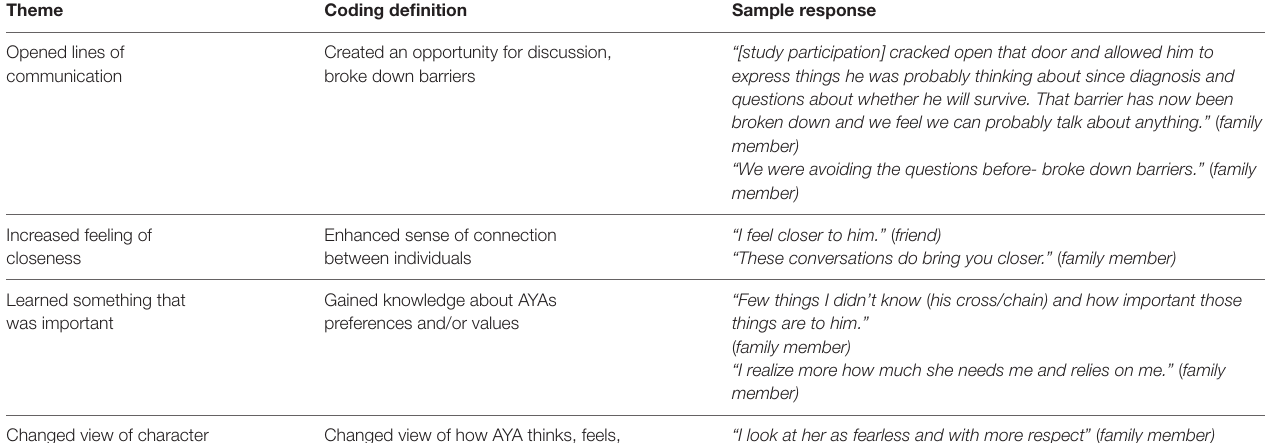
TABLE 2 | Perceived changes in relationship post-VMC